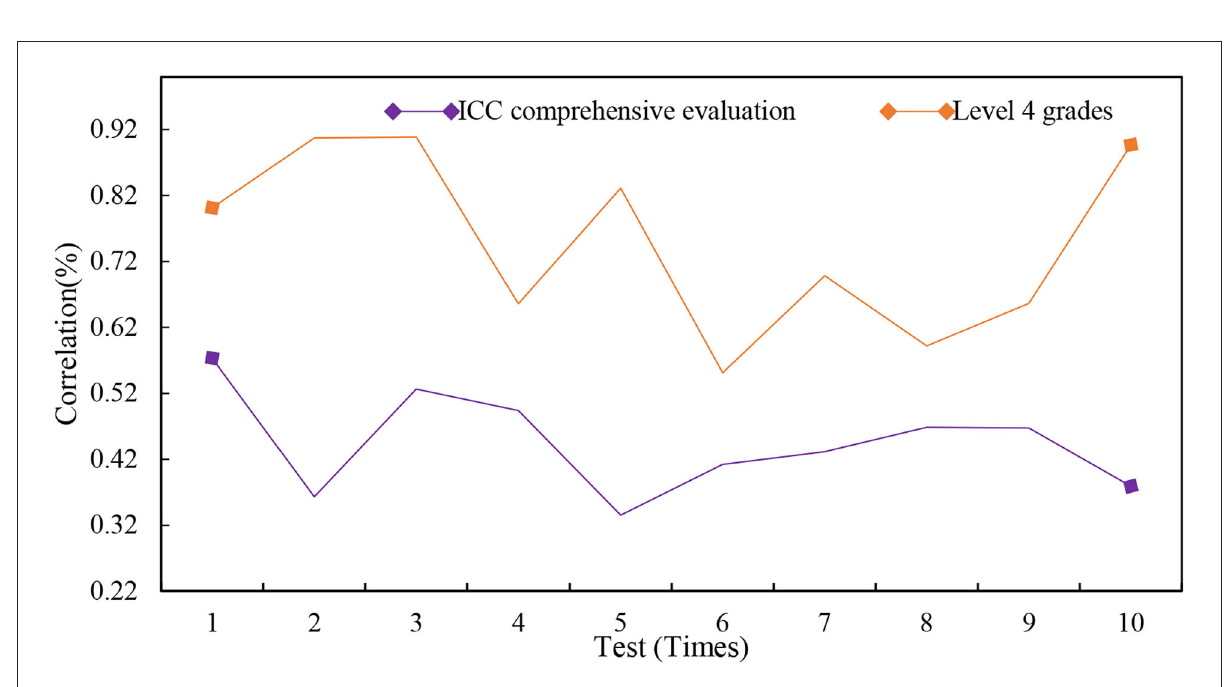
FIGURE9 Significance